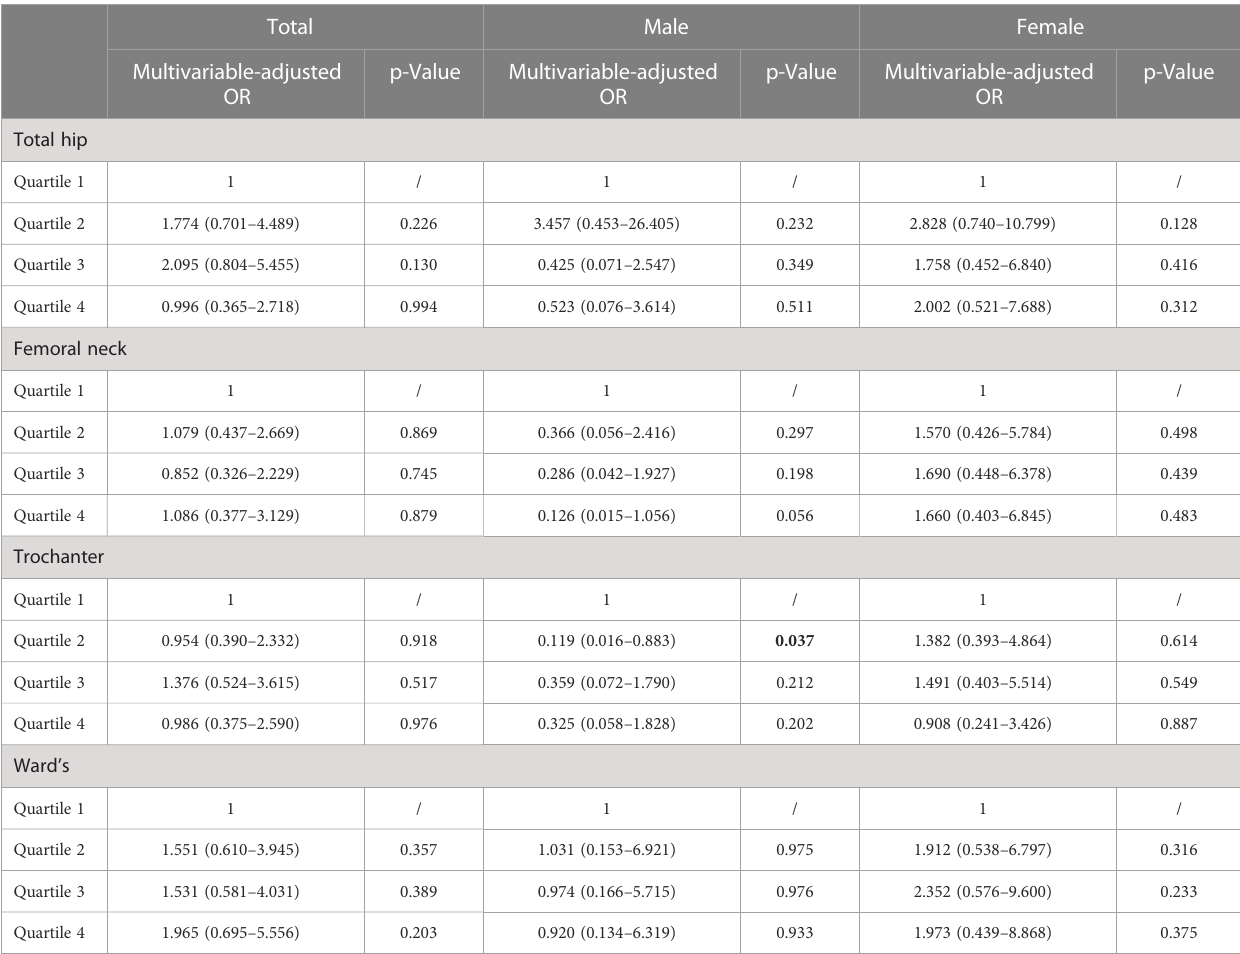
TABLE 3 Multivariable-adjusted ORs of hyperuricemia according to hip bone mineral density level in obese